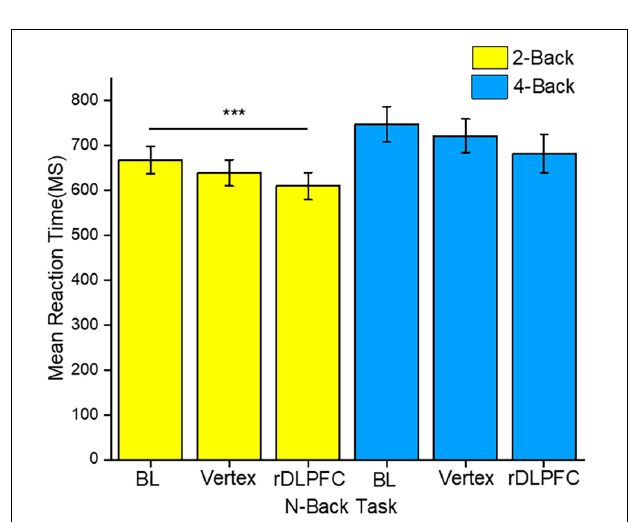
FIGURE 4 | The reaction time (RT) performance for both 2-back and 4-back tasks. The yellow and blue colors indicate 2-back and 4-back tasks, respectively. The asterisks indicate the level of significance, with *** indicating p ≤ 0.001. The errors bars indicate the standard mean error